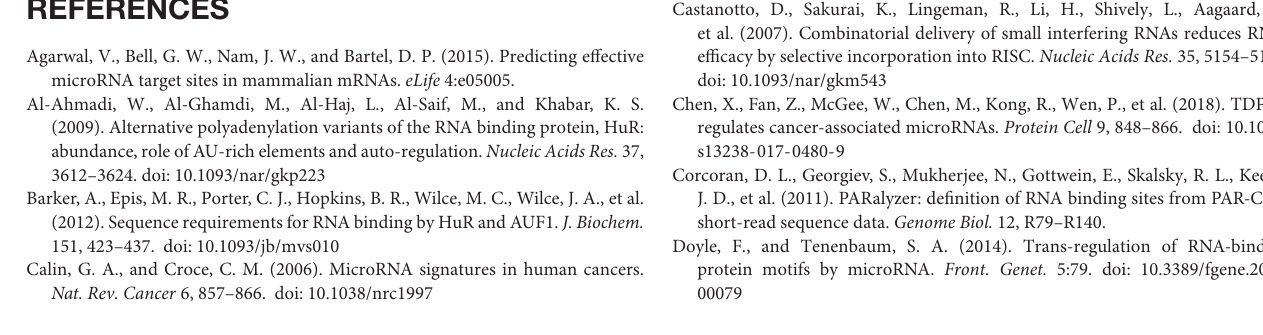
LUAD, LUSC, PRAD, and THCA. Column 10 represents the number of the pair occurrences in multiple cancers. We sorted these rows in descending order according to column 10. TABLE S15 | Complete list of significant RBP-microRNA-mRNA trios in seven cancers. (Please see website: http://sites.utoronto.ca/zhanglab/papers/RBP_miR/). We used q -value less than 0.05 to screen the RBP-microRNA-mRNA trios for each cancer and count the number of their occurrences in multiple cancers. Column 1, 2 and 3 represent microRNA, RBP, and mRNA. Column 4, 5, 6, 7, 8, 9, and 10, respectively represent the p -value/ q -value calculated in BRCA, KIRC, LIHC, LUAD, LUSC, PRAD, and THCA. Column 11 represents the number of the trio occurrences in multiple cancers. We sorted these rows in descending order according to column 11. TABLE S16 | Top 100 significant RBP-RBP pairs in seven cancers. TABLE S17 | Top 100 significant RBP-RBP-mRNA trios in seven cancers. TABLE S18 | Complete list of significant RBP-RBP pairs in seven cancers. TABLE S19 | Complete list of significant RBP-RBP-mRNA trios in seven cancers. (Please see website: http://sites.utoronto.ca/zhanglab/papers/RBP_miR/). TABLE S20 | Top 100 significant microRNA-microRNA pairs. TABLE S21 | Top significant microRNA-microRNA-mRNA trios. TABLE S22 | Complete list of significant microRNA-microRNA pairs. TABLE S23 | Complete list of significant microRNA-microRNA-mRNA trios. TABLE S24 | Summary of regression results. (A) The summary of regression results on RBP-RBP-mRNA. Each row represents a type of cancer. Column 2, 3, and 4, respectively represent the number of RBP,RBP, mRNA which show in our processed TCGA tumor samples. Column 5 represents the number of screened by regression